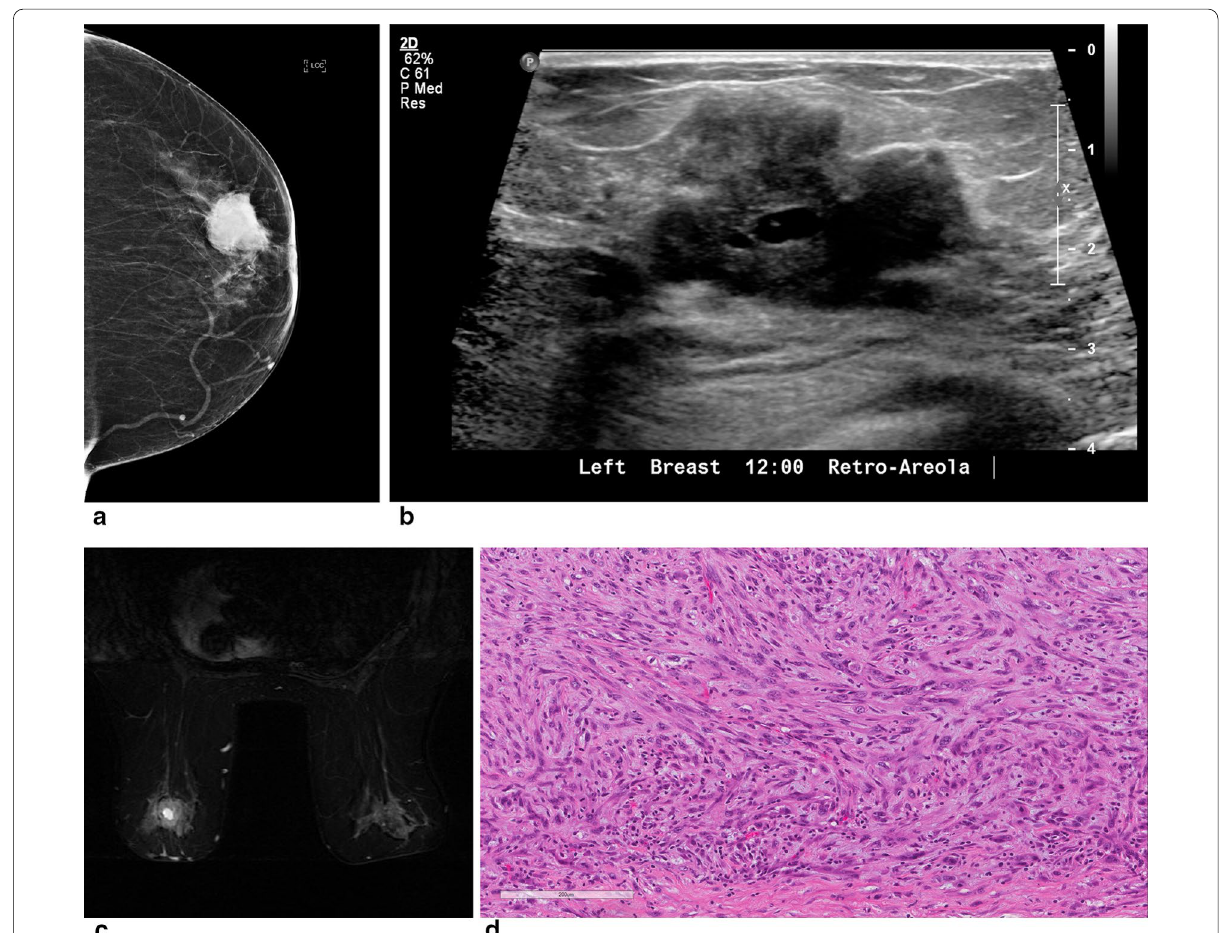
Fig. 2 A left breast mass in a 69-year-old woman with a spindle cell carcinoma subtype. a The craniocaudal view of mammogram shows an irregular shape, high density mass with indistinct margins located at outer aspect. b The ultrasound reveals a microlobulated, irregular, complex mass in the left breast with central cystic area. c MRI T2-weighted image reveals a central hyperintense area representing necrosis. d The pathology shows the tumor is entirely composed of spindle